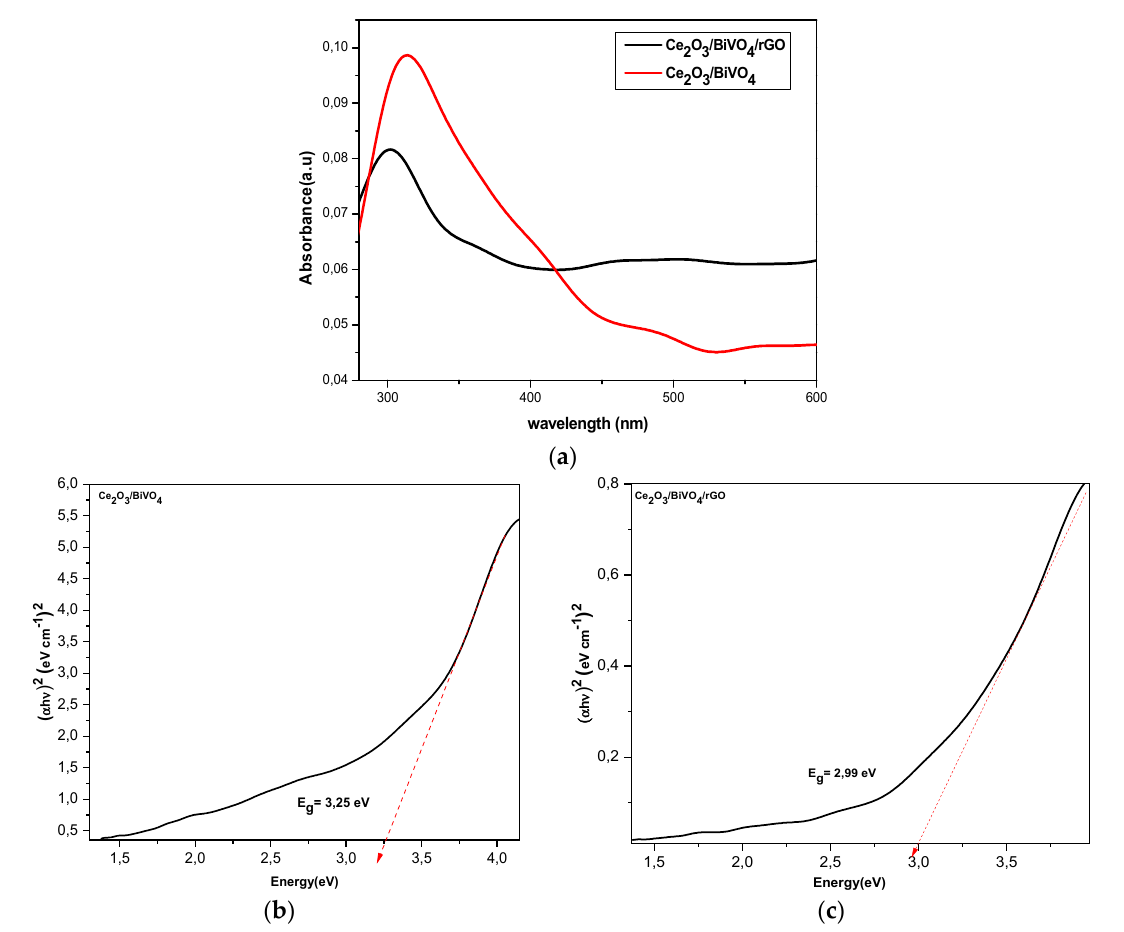
Figure 6. ( a ) UV–visible spectra of Ce 2 O 3 /BiVO 4 and Ce 2 O 3 /BiVO 4 /rGO; Tauc plot for ( b ) Ce 2 O 3 /BiVO 4 and ( c ) Ce 2 O 3 /BiVO 4 /rGO.